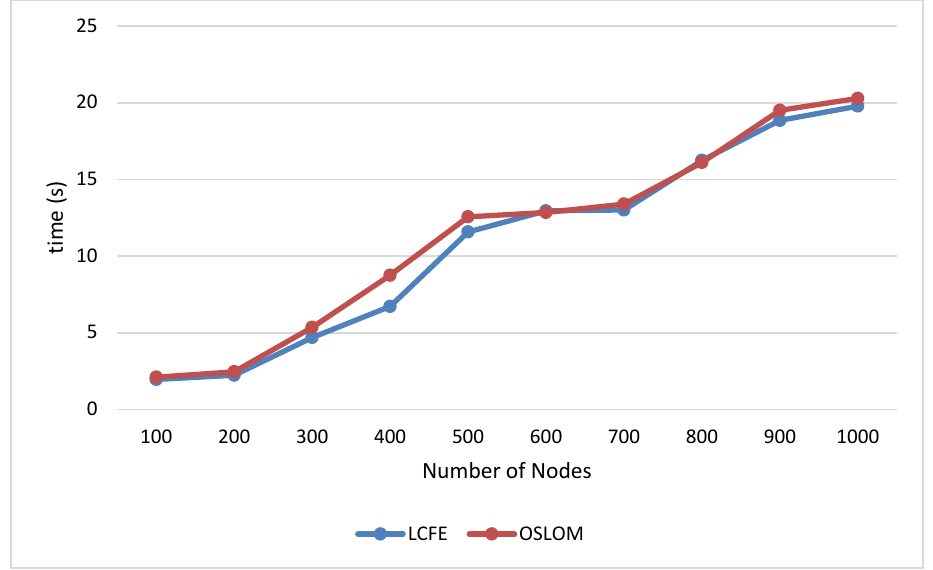
Fig. 19. Run Time Analysis of LCFE and